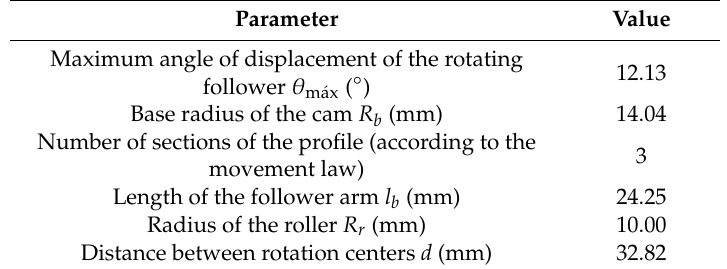
Figure 4. ( a ) Measured parameter values in the reference cam-follower mechanism (length units are mm); ( b ) segments of the profile and maximum follower angular displacement. Table 1. Numerical values of the start design parameters (according to Figure 4a,b).